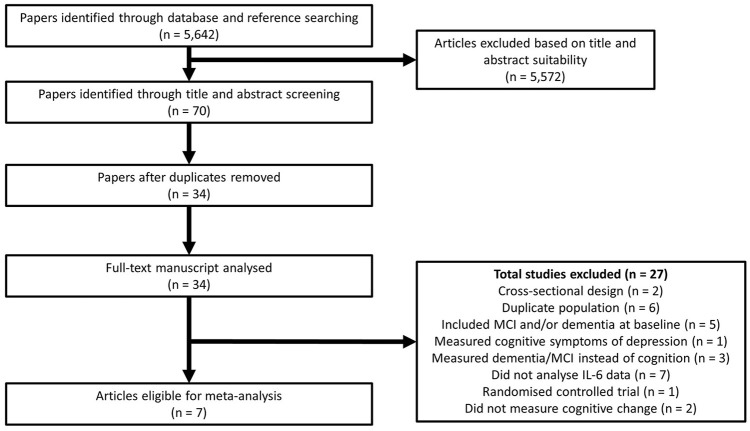
Flowchart summarizing the literature search for the meta-analysis.